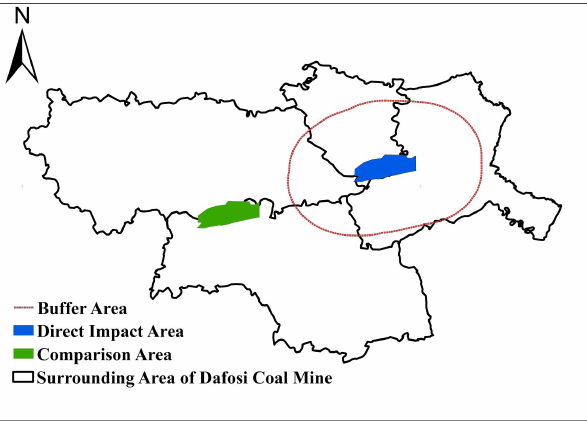
Figure 10. Locations of the coal mine area, buffer area, and comparison area.